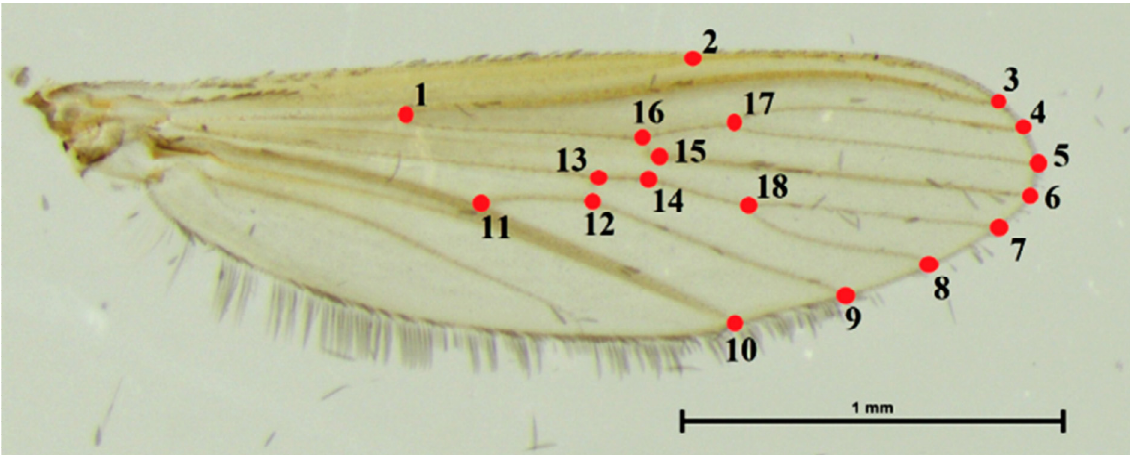
Figure 2. Location of the 18 wing landmarks used in the geometric morphometric analyses.